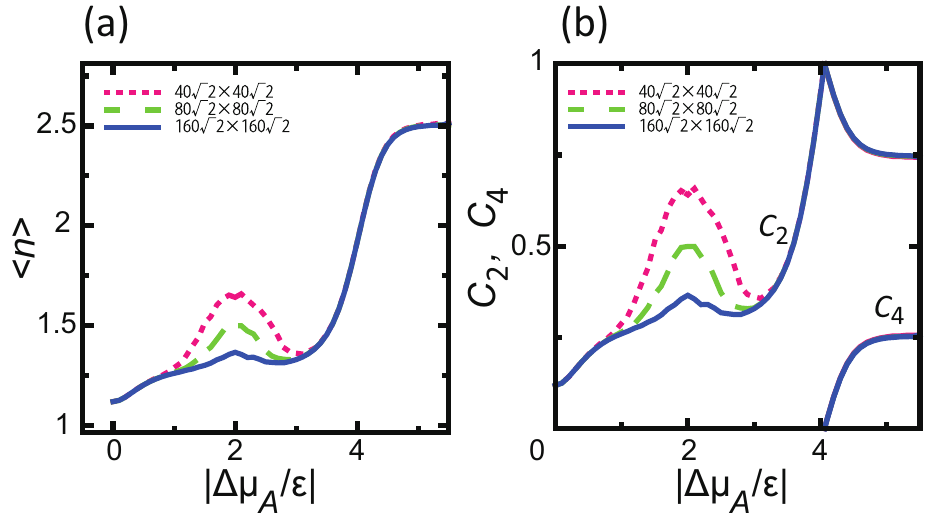
Figure 5. ( a ) ∆ µ A dependence of average height of merged steps (cid:104) n (cid:105) (Equation (17)). Averaged over 1 × 10 8 MCS/site. ( b ) ∆ µ A dependence of the double and quadruple step ratios C 2 and C 4 , respectively (Equations (18) and (19)). k B T / (cid:101) = 0.2. ¯ p = 0.530. For 1 ≤ ∆ µ A / (cid:101) ≤ 3, (cid:104) n (cid:105) is about 1.25 for a large system. The fraction of double steps c is estimated using the following